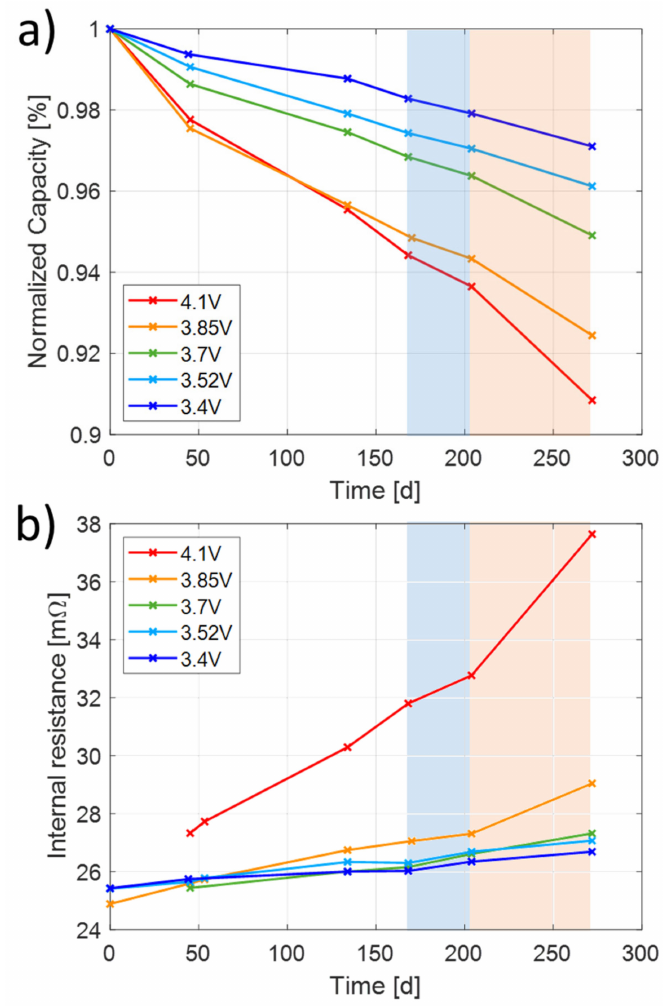
Figure 2. Normalized ( a ) capacity tests and ( b ) pulse tests (evaluated at 3.7 V after 10 s) over test time for all five cell potentials. The low temperature cycle is in blue and the high temperature cycle in